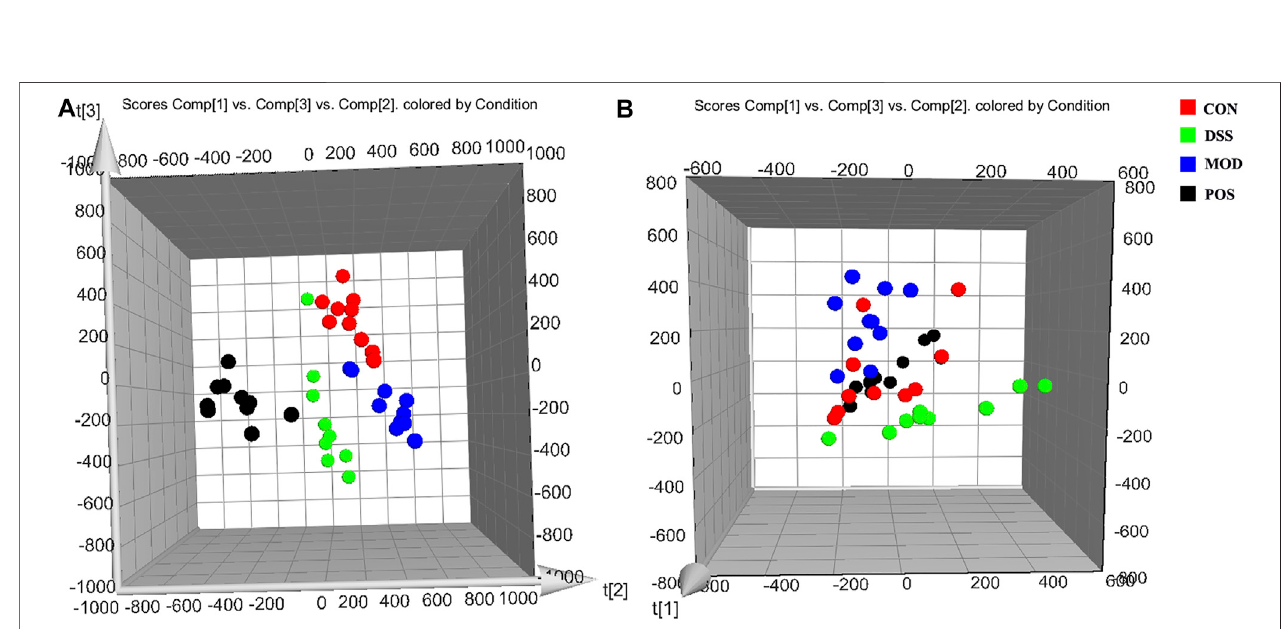
FIGURE2| 3DPCA scoreplotoftheurinesamplesineachgrouponthe10thdaygeneratedbyEzinfo3.0software. (A) Negativeionmode. (B) Positiveionmode.